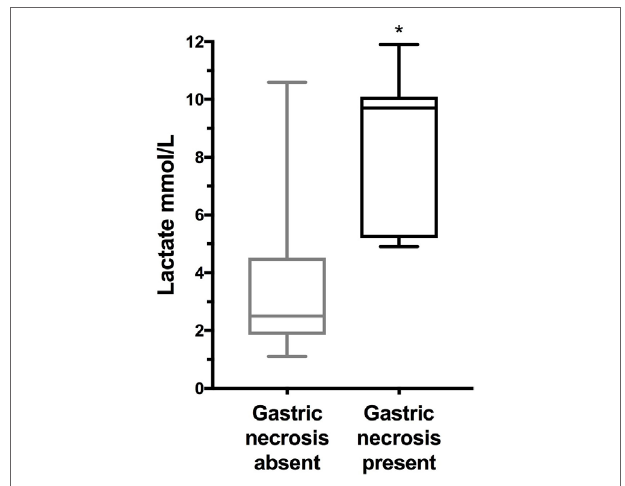
FigUre 3 | Box and whisker plot comparison of blood lactate concentrations from 22 dogs with gastric dilatation–volvulus (GDV) without gastric necrosis, and 7 dogs with GDV and gastric necrosis. The central line represents the median, the boxes represent the interquartile range, and the whiskers represent the minimum and maximum values. * indicates statistical significance at P < 0.05. Dogs with gastric necrosis had significantly higher lactate concentrations compared to dogs without gastric necrosis by Mann–Whitney U -test ( P = 0.0005).